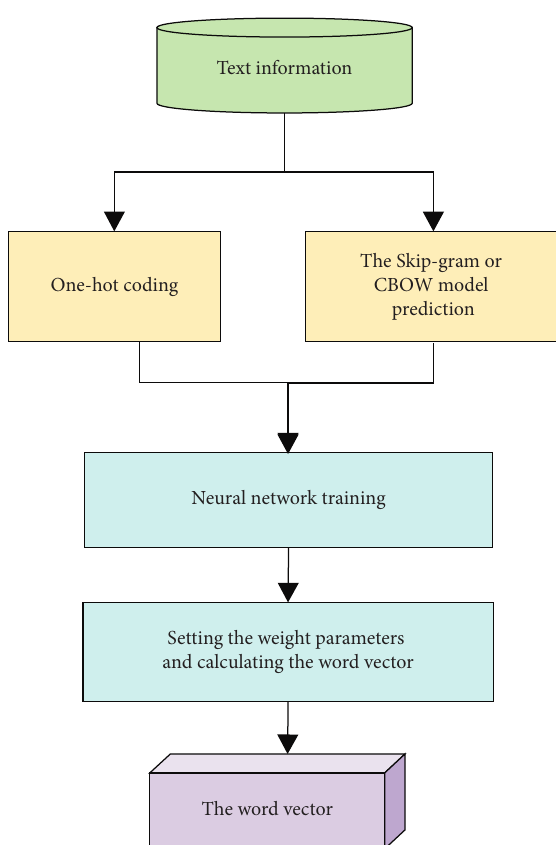
Figure 6: Flowchart of word vector